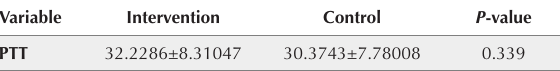
Note . PTT: Partial thromboplastin time. Table 4. Mean (standard deviation) volume of discharge in intervention and control groups Lung secretion